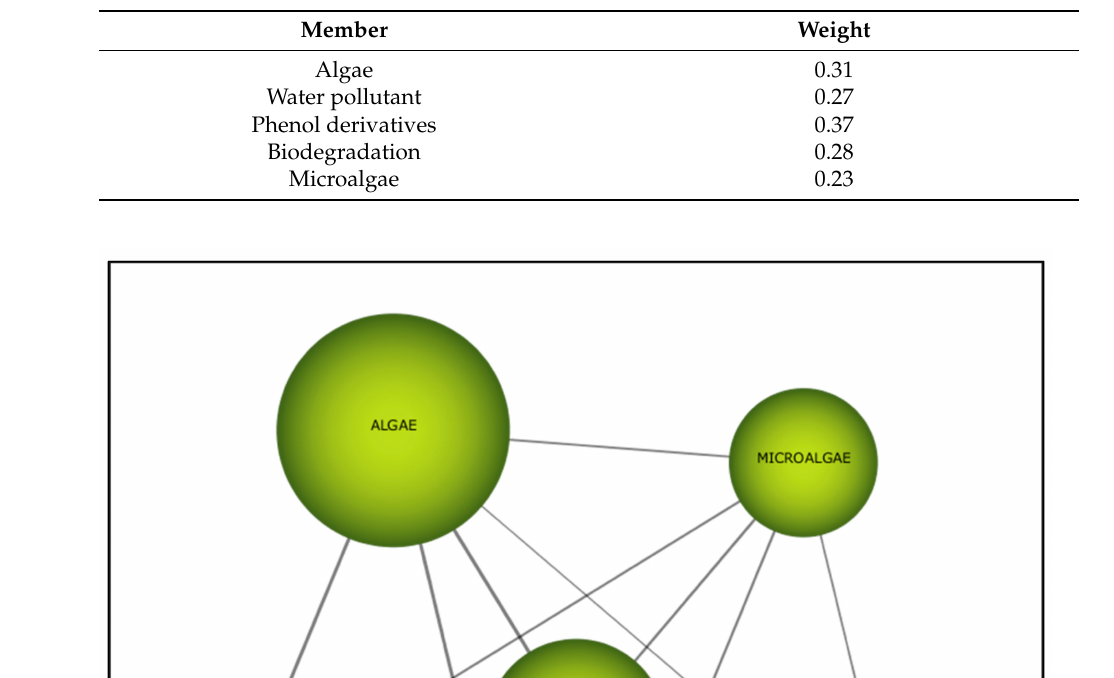
Table 8. The weight of lines connected to the main theme “phenols”.